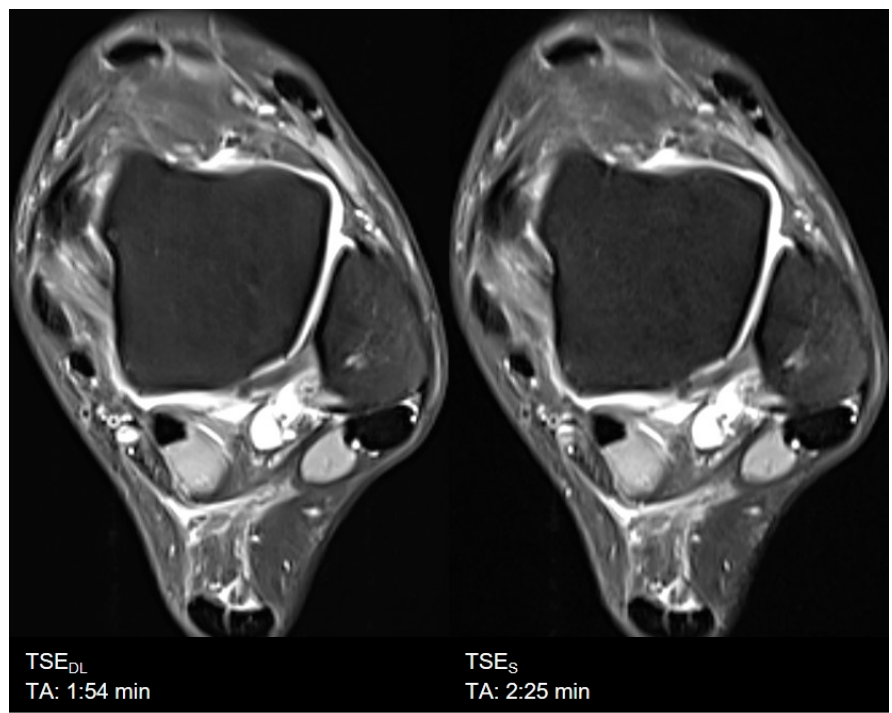
Figure 7. Example of a Deep Learning ( left ) and standard ( right ) PD-weighted turbo spin echo image of the ankle in axial orientation.